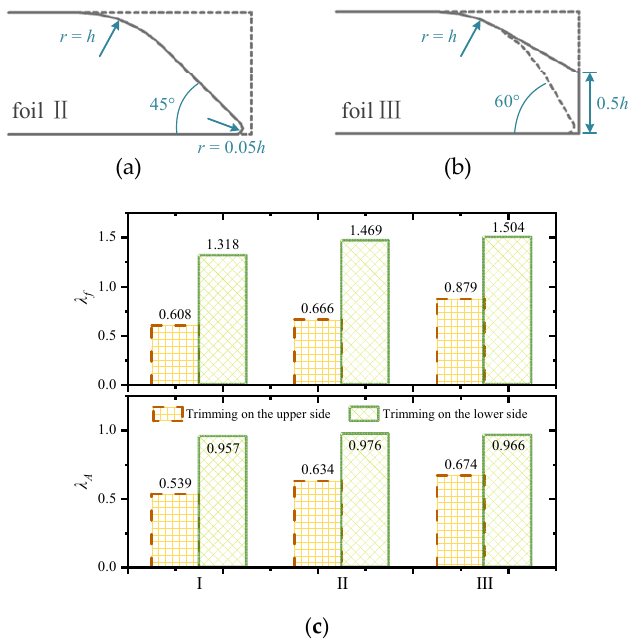
Figure 14. Effectiveness of trimming in different ways: ( a ) schematic of trimming II, ( b ) schematic of trimming III, and ( c ) effectiveness of trimming with α = 1.4.